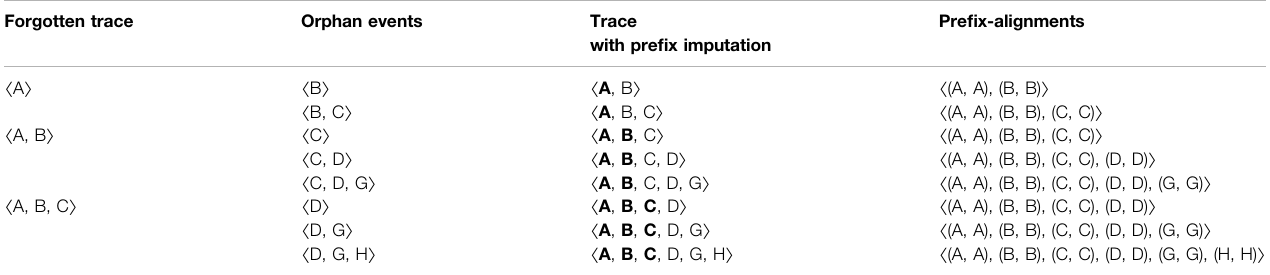
TABLE3| Examplepre fi x-alignmentsforcase “ 7 ” ofeventlogof Table1 withourproposedimputationapproachandforgettingatdifferentpre fi xlengths.Theimputedpre fi x for each trace is represented in bold. Forgotten